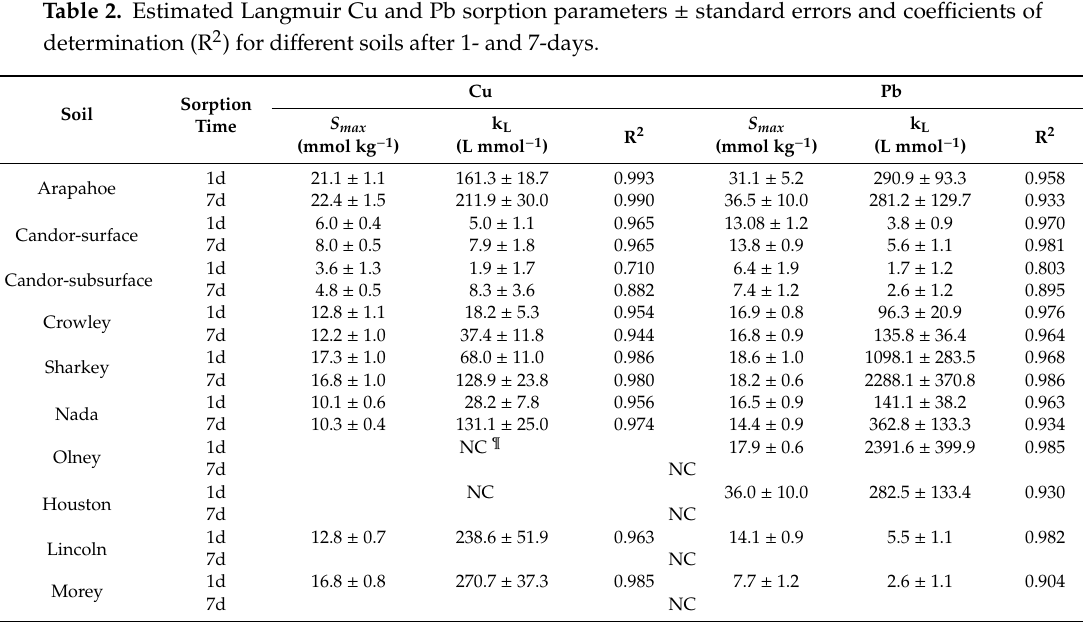
¶ : Langmuir fitting did not